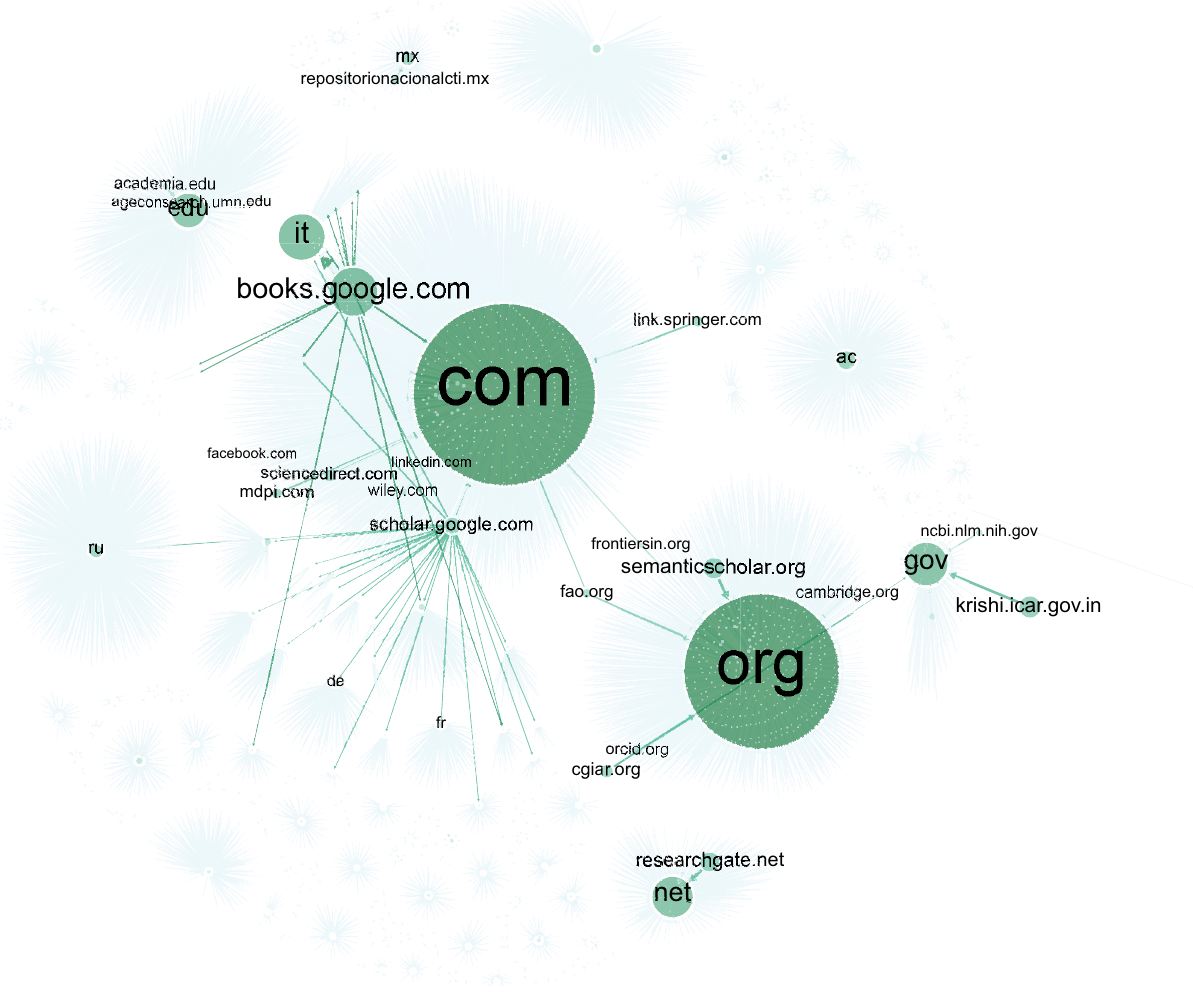
Figure 5. Network visualization of Top-Level Domain